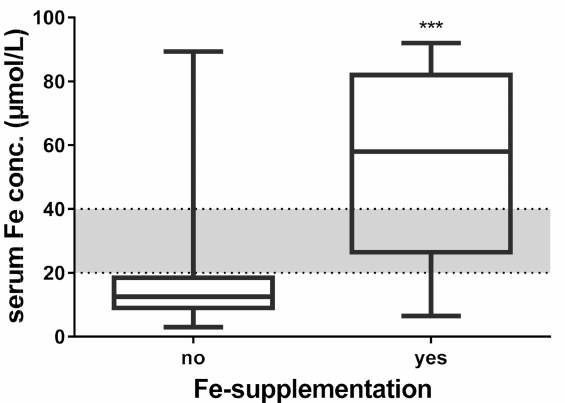
Figure 1. Serum Fe concentration of calves with and without oral iron supplementation ( n = 123, calves receiving supplementation: no, n = 106; yes, n = 17), normal range highlighted in grey, *** p <